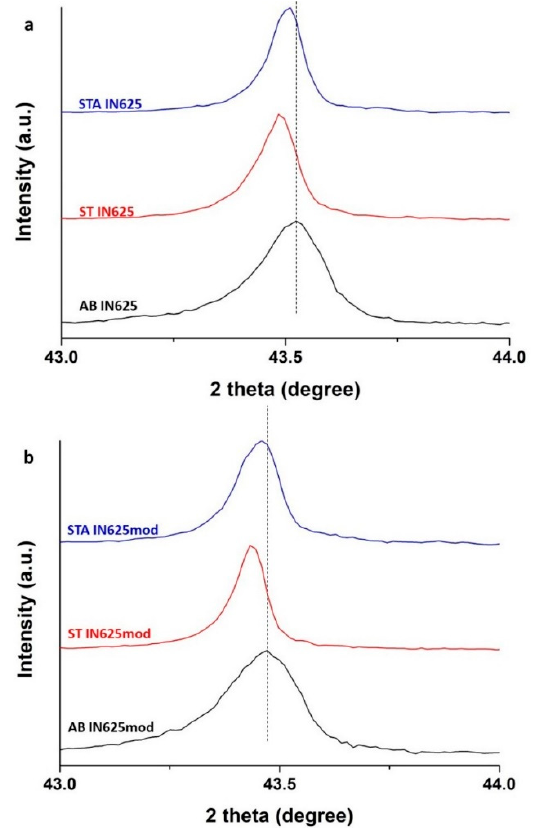
Figure A3. XRD patterns of the peak (111) of the ( a ) IN625 and ( b ) IN625mod in the AB, ST, and STA conditions. Figure A4.